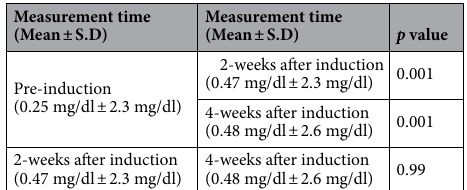
Measurement time (Mean ±